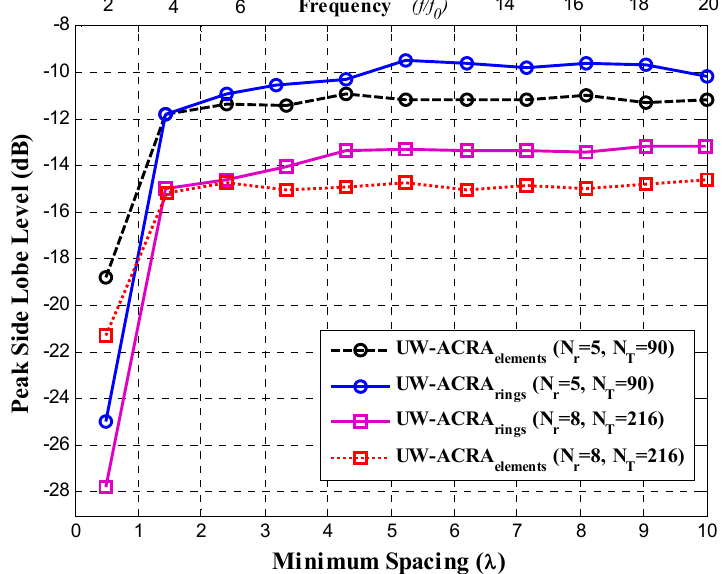
Figure 5. Comparison of the PSLL performance between the case of UW-ACRA elements and the case UW-ACRA rings .